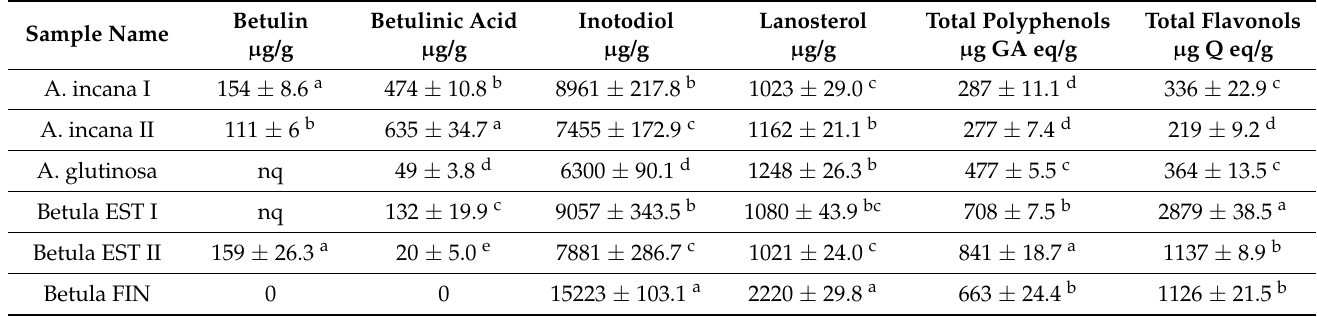
Table 2. Triterpenoids and polyphenolic compounds in the conk